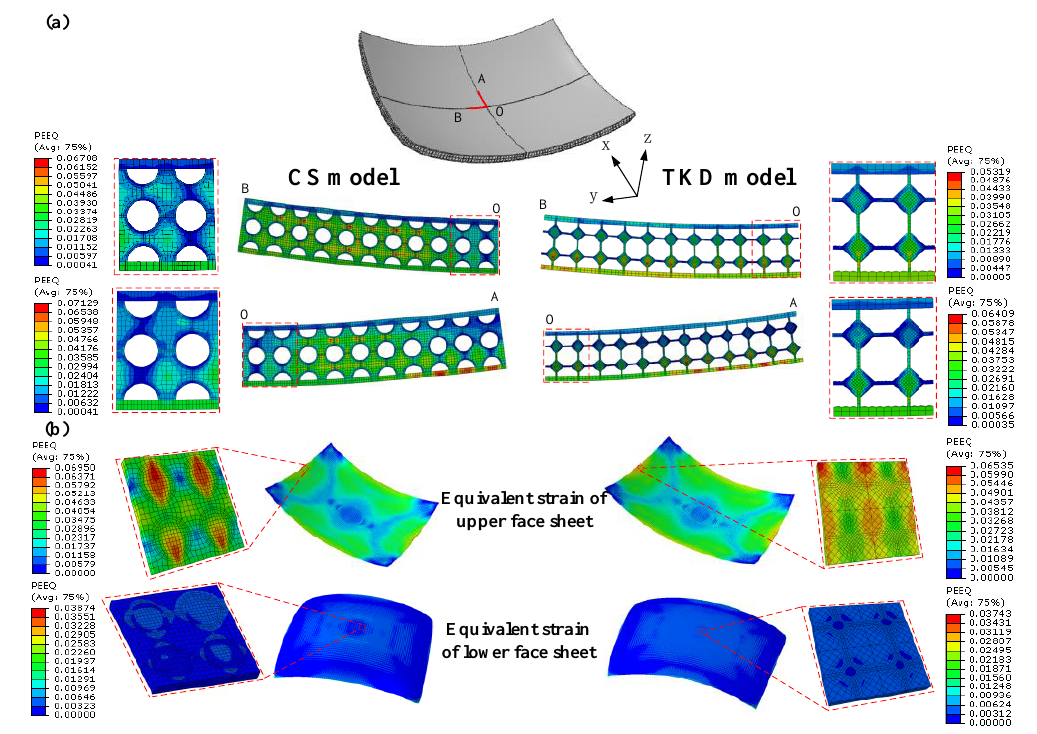
Figure 3. ( a ) Equivalent strain of cross section in the central region of spherical AFSP. ( b ) Equivalent strain of upper and lower face sheet of spherical AFSP.